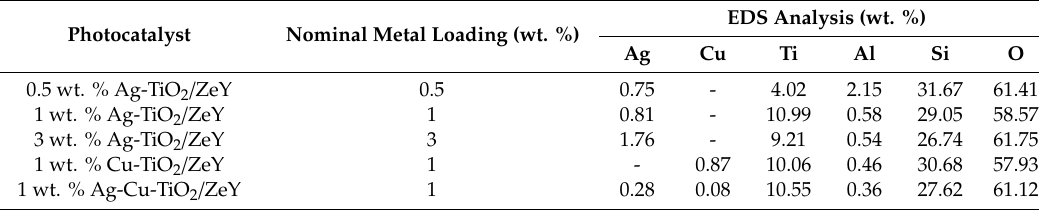
Table 2. Results from elemental analysis (from EDS) of